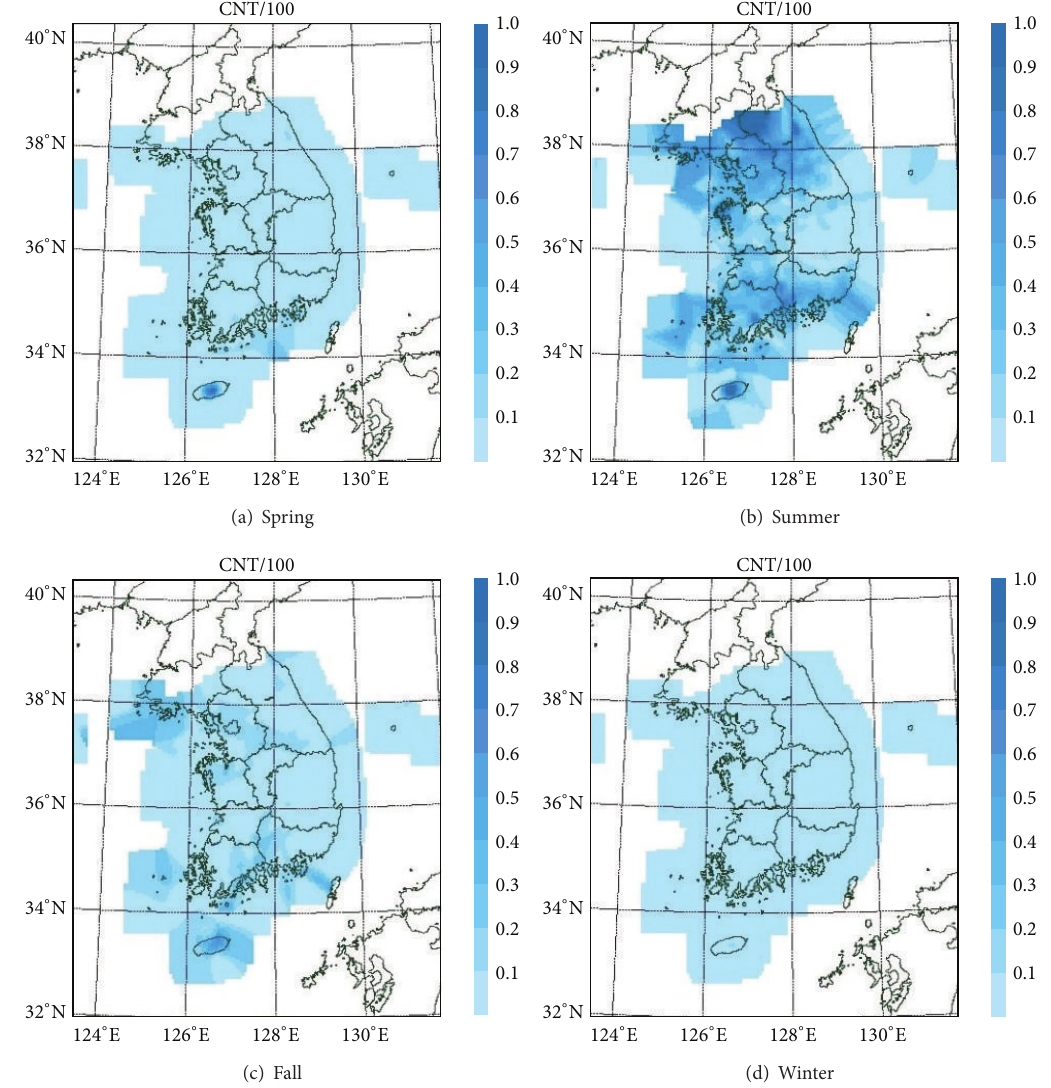
Figure 12: The distribution of heavy rainfall by seasons